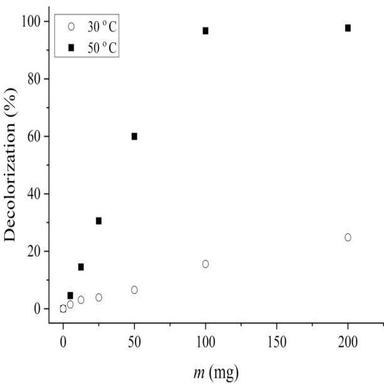
Influence of mass of catalyst on decolorization of tartrazine at two different temperatures.